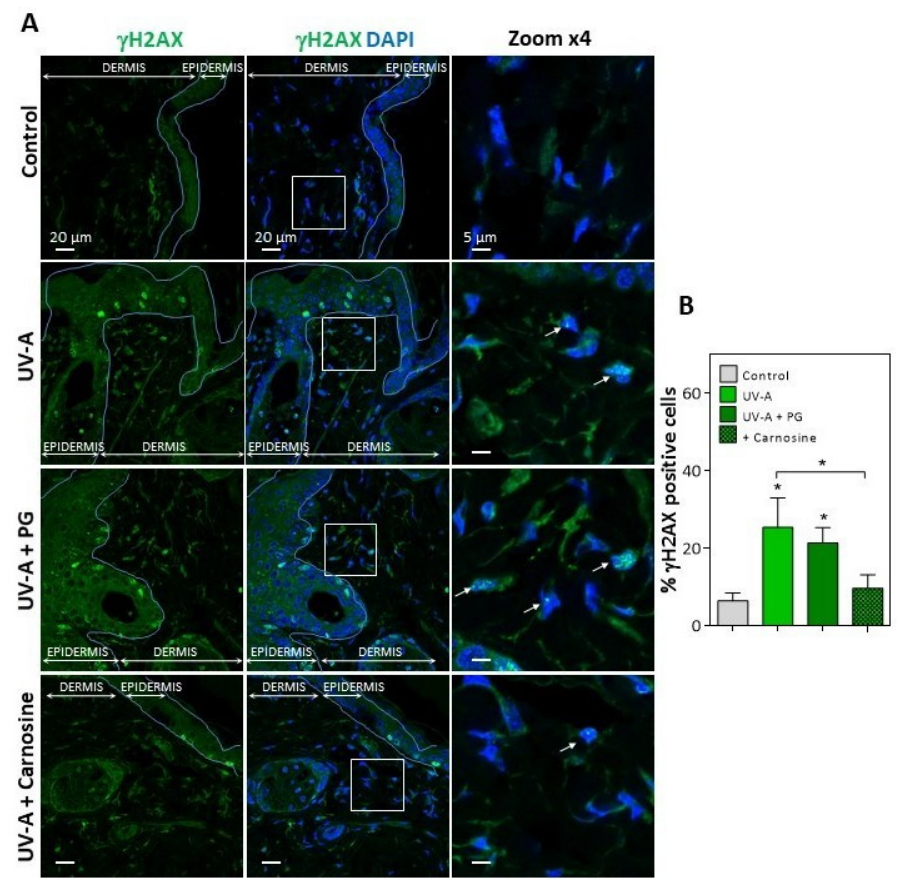
Figure 2. Expression of γ H2AX in the skins of UV-A-exposed hairless mice. ( A ), immunofluorescence and confocal imaging of γ H2AX (green) in skin fibroblasts from hairless mice untreated (control), UV-A-exposed (UV-A), UV-A-exposed/propylene glycol (UV-A+PG), and UV-A-exposed + carnosine (1% in PG). Nuclei were stained with DAPI (blue). Scale bar, 20 µ m. Inserts indicate the area selected for higher magnification × 4, right panels. White arrows indicate the γ H2AX positive nuclei. ( B ), statistical quantification of the percentage of γ H2AX positive cells in the dermis area. The data are expressed as medians ± interquartile range. Statistical significance was assessed using the nonparametric Mann-Whitney U test (* p < 0.05).